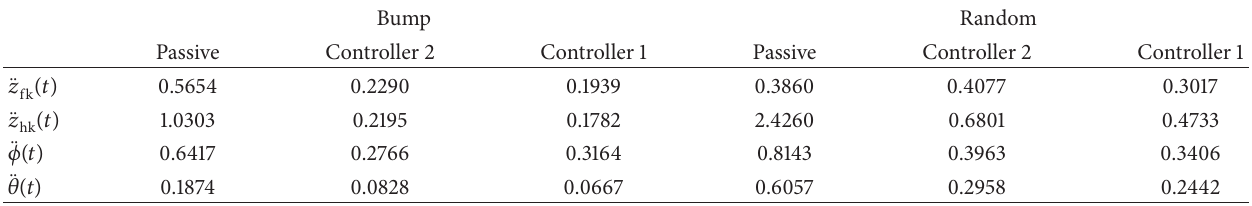
Table 3: Comparison of peak values of acceleration responses for both controlled and uncontrolled